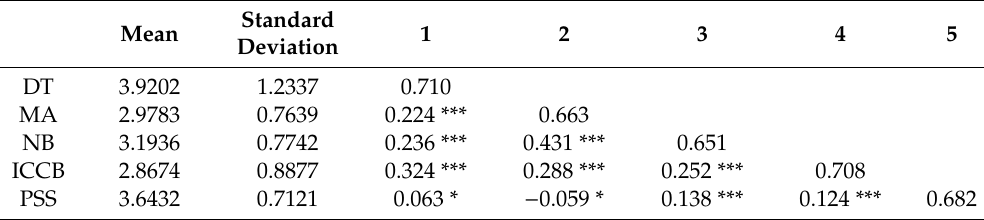
Table 2. Mean, standard deviation and correlation coe ffi cient matrix ( N =